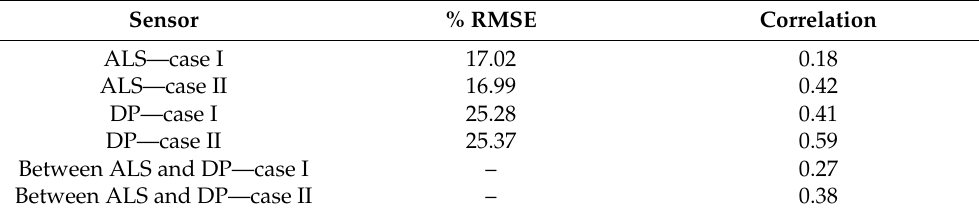
Table 4. Relative root mean square errors (%RMSEs) and plot level residual correlations between predictions using the same sensor and across sensors.